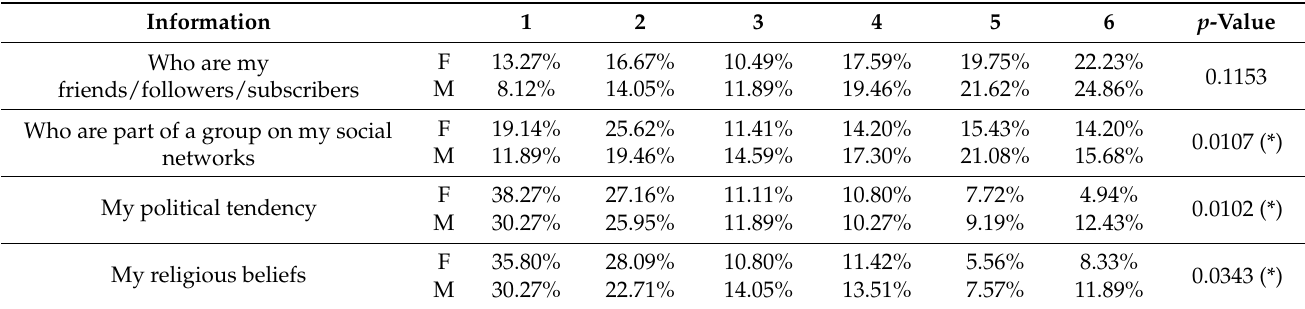
Table 11. Frequency with which you usually define as “public” personal information on websites and/or social networks. Information Who are my friends/followers/subscribers Who are part of a group on my